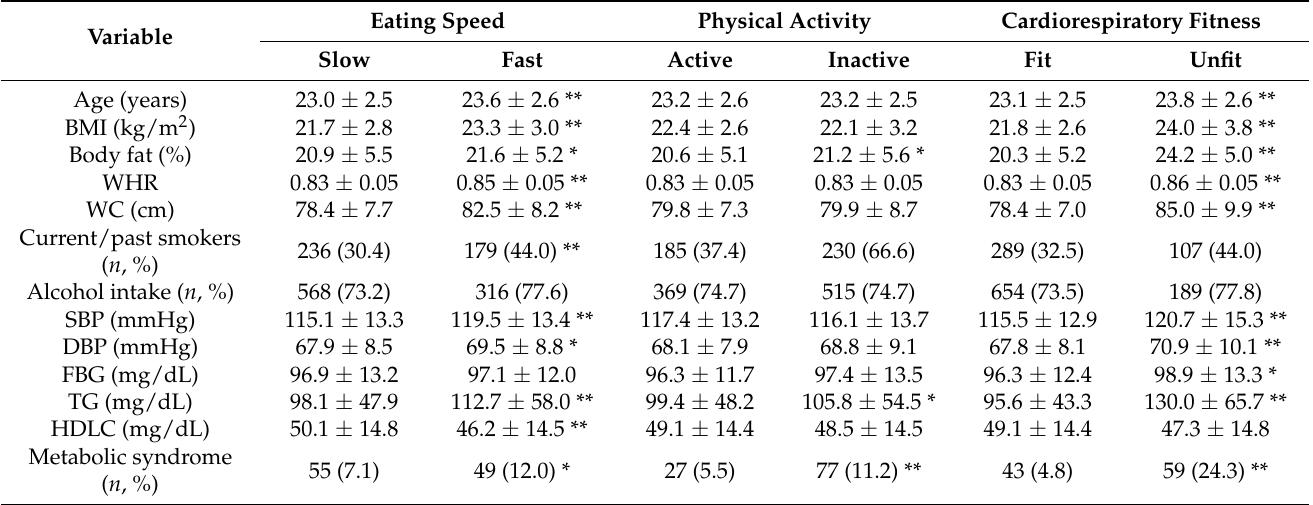
Table 2. Descriptive statistics of study participants by eating speed, physical activity, and cardiorespiratory fitness.